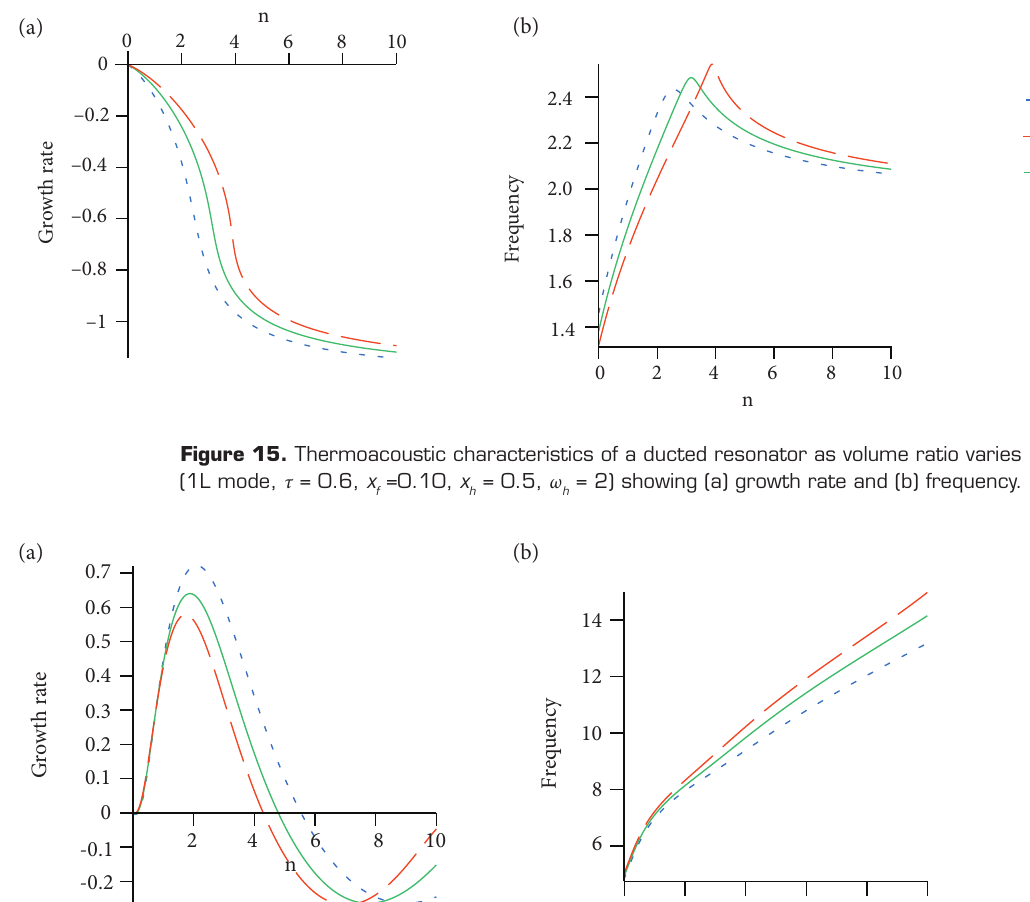
= 0.10, x = 0.5, ω = 2) f h h